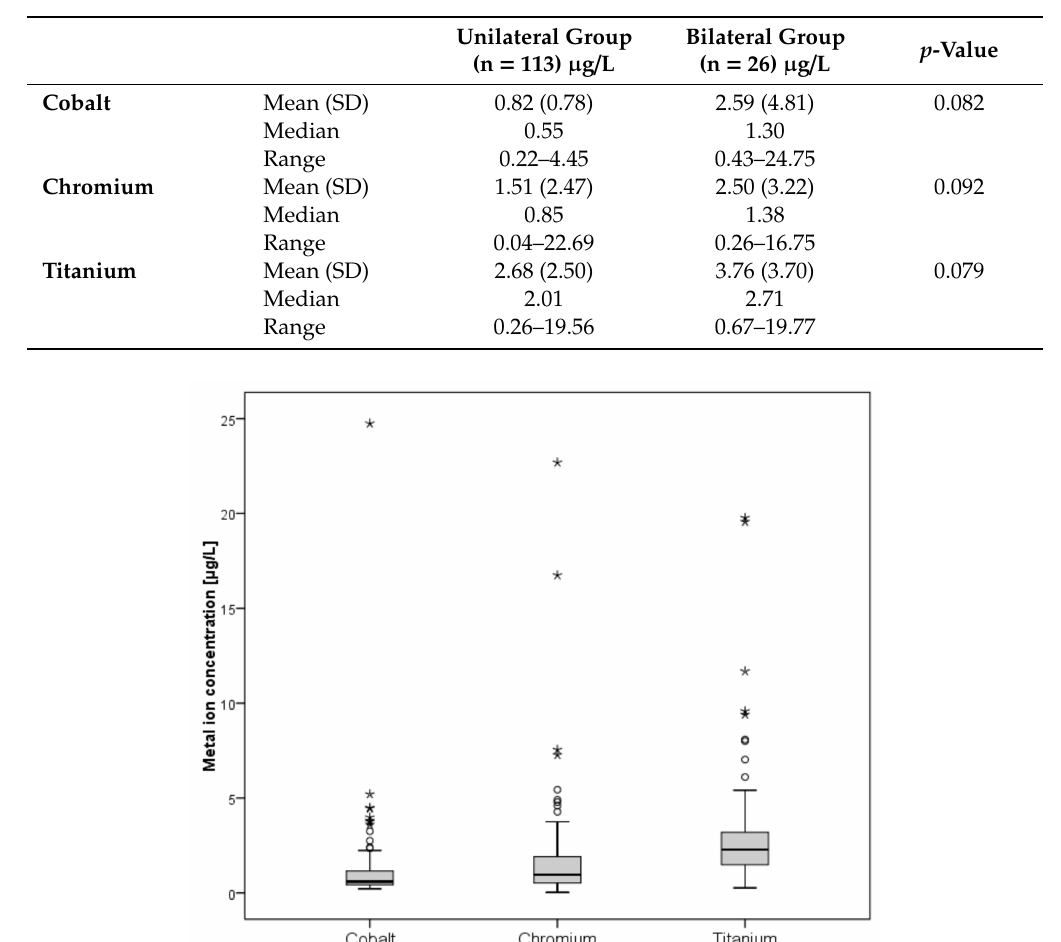
Figure 4. Box-and-whisker plots showing whole blood ion concentrations of cobalt, chromium, and titanium. The box marks the range between first and third quartile, with the band inside the box indicating the median and whiskers indicating minimum and maximum data